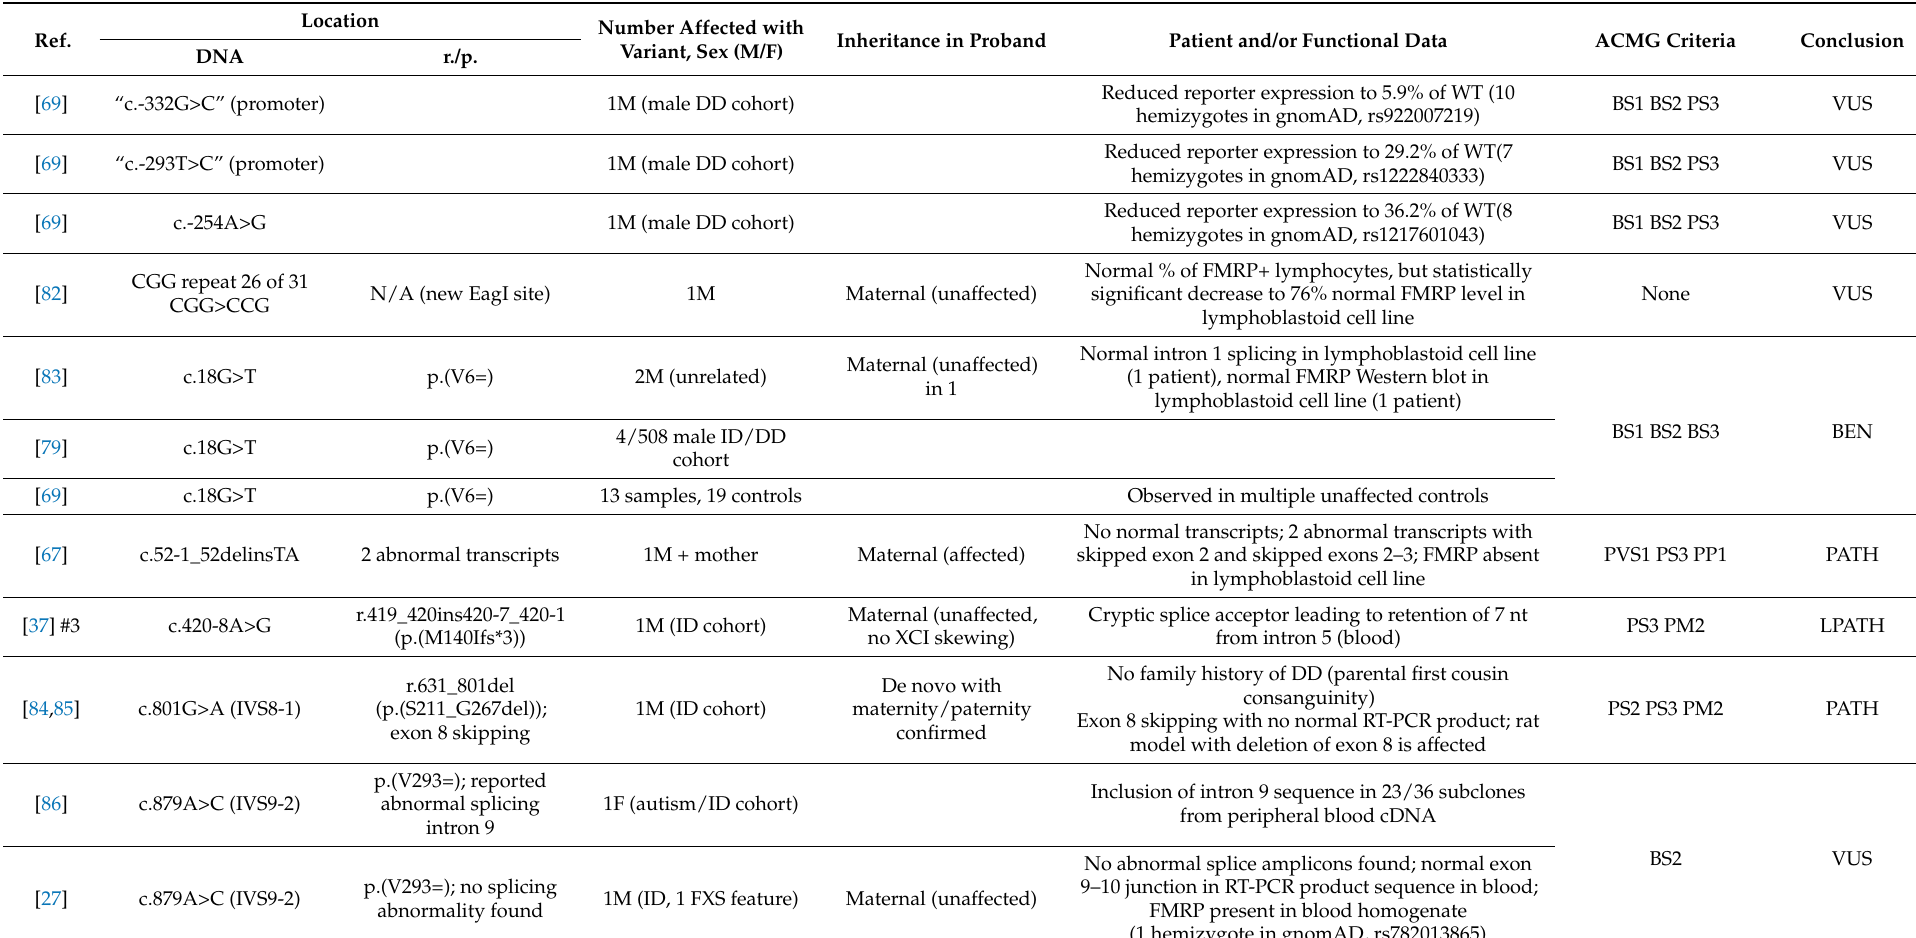
Table 4. Noncoding FMR1 variants reported as pathogenic or possibly